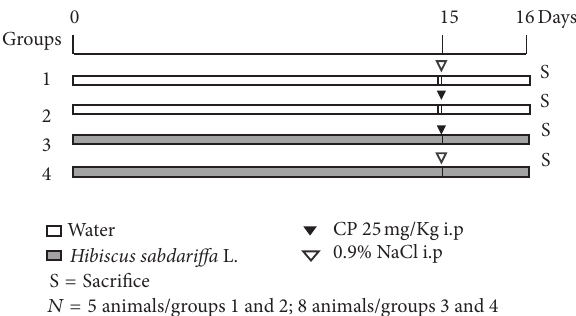
Figure 1: Experimental protocol for determination of antimuta- genic/mutagenic effect of the Hibiscus sabdariffa L. in bone marrow cells of Wistar